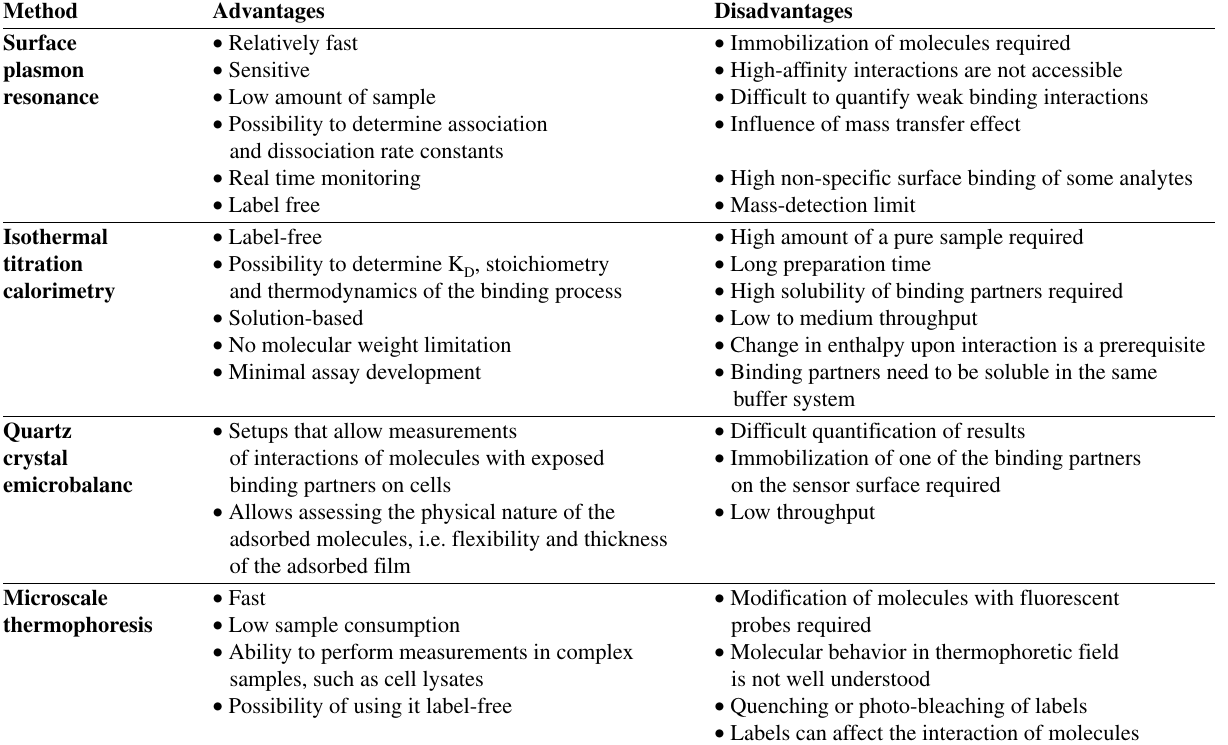
Table 1. Advantages and disadvantages of some of the most commonly used biophysical methods for studying molecular interactions.